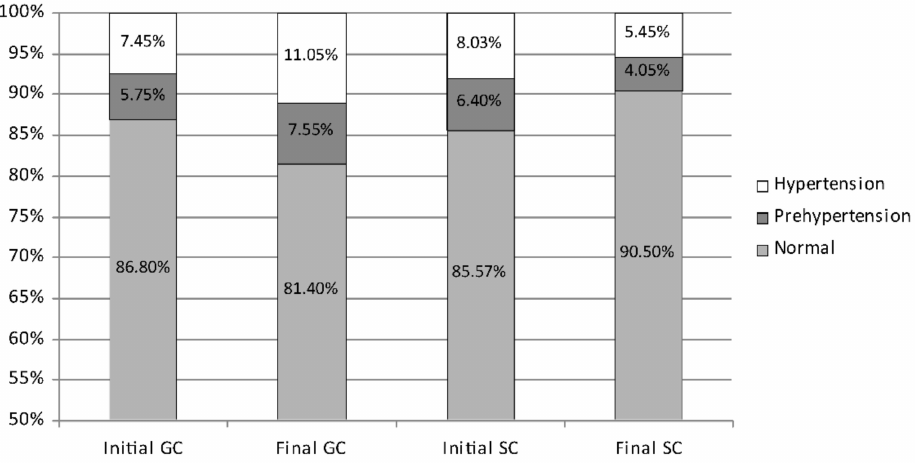
Figure 5. The percentage of girls with diastolic prehypertension, hypertension, and normal blood pressure—comparison between the initial and the final measurement sessions. GC—general educa- tion classes (standard PE, 4 h a week); SC—sport classes (elevated PE, 10 h a